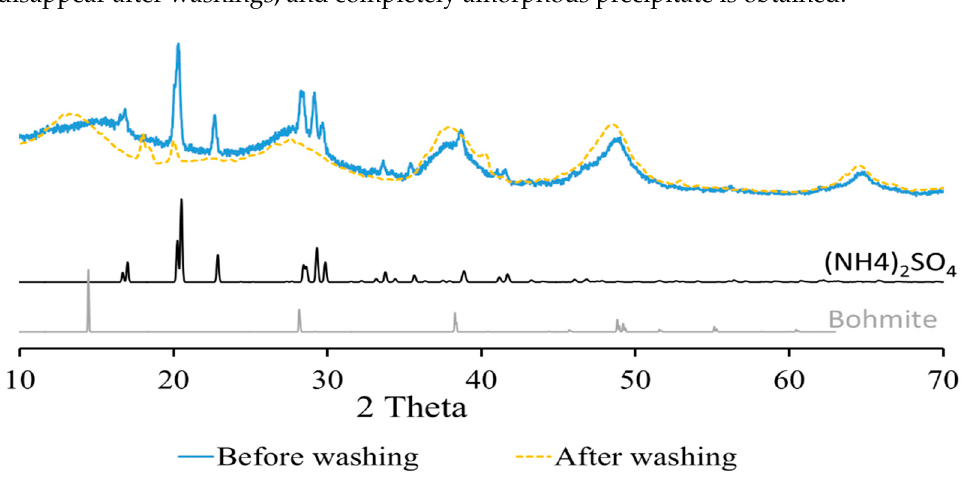
Figure 9. X-ray pattern of the alumina precipitate (before the washing). Patterns of mascagnite ((NH 4 ) 2 SO 4 ) and bohemite (AlOOH) are given from Ruff database [28,29].